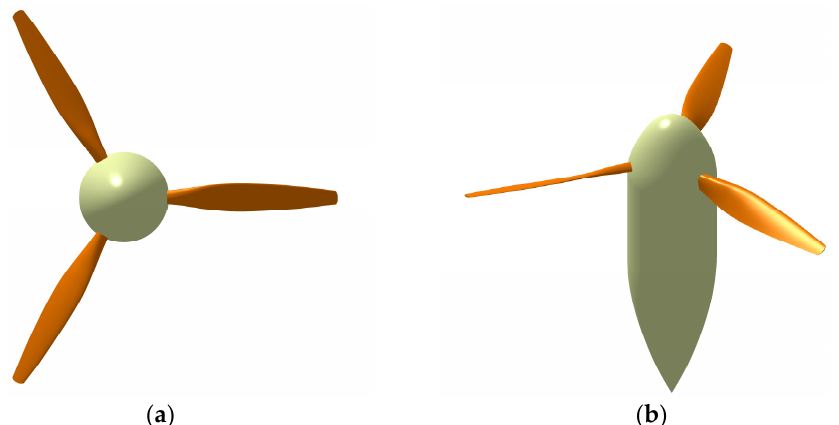
Figure 7. The distribution of chord-length, twist angle and relative thickness of a 3-blade NACA 5868-9 propeller.